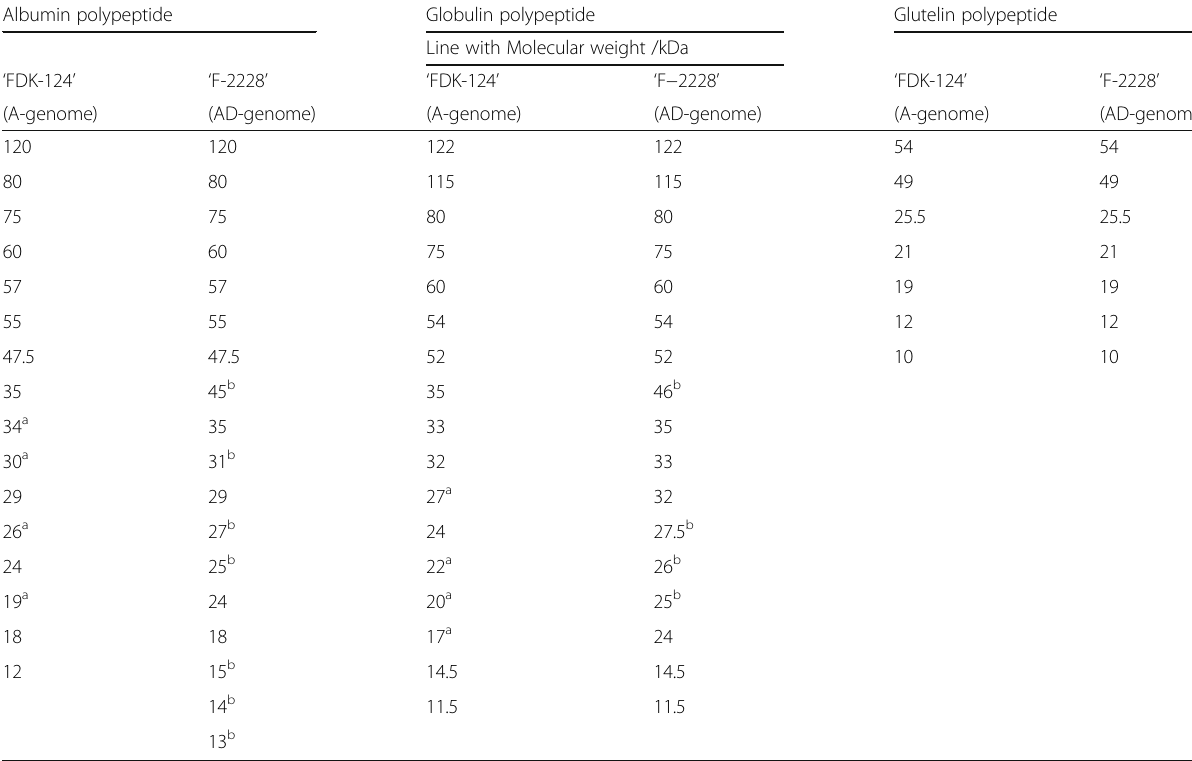
Table 7 Polypeptide composition of seed protein fractions in selected lines of two Gossypium species under reducing conditions Albumin polypeptide